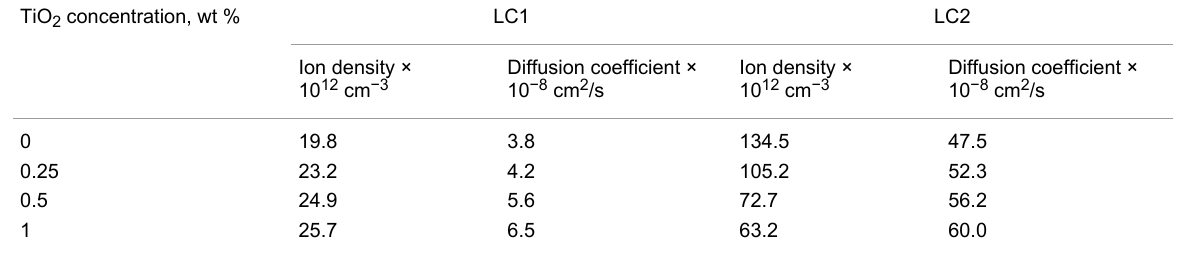
Table 1: Ion density and average diffusion coefficient of LC1, LC2 and their